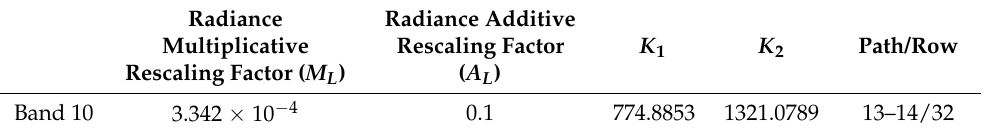
Table 1. Rescaling factor and thermal constant values along with path/row of Landsat–8 TIRS band 10 used in this